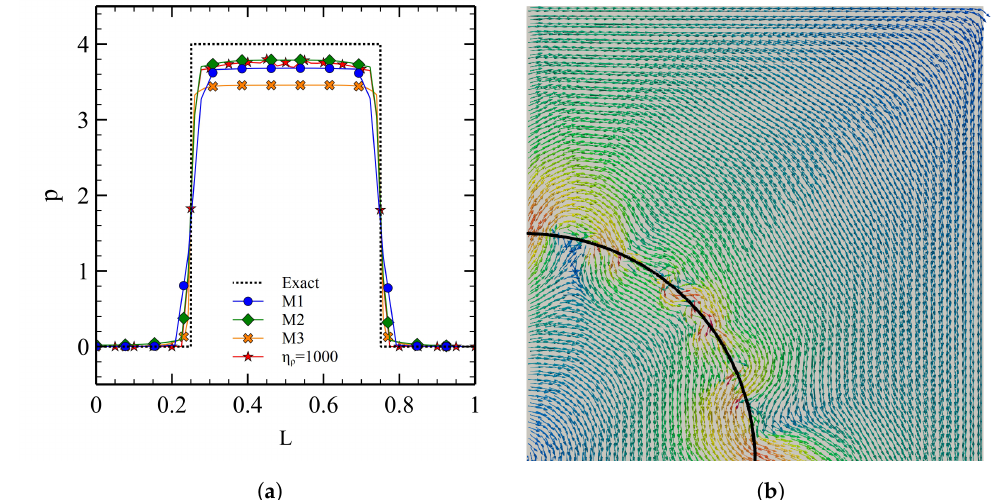
Figure 2. Pressure profile on the horizontal axis passing through the centre of the model ( a ) and velocity vectors on the upper-right quarter, representing the spurious velocities, for the M3 mesh ( η ρ = 1) ( b ).